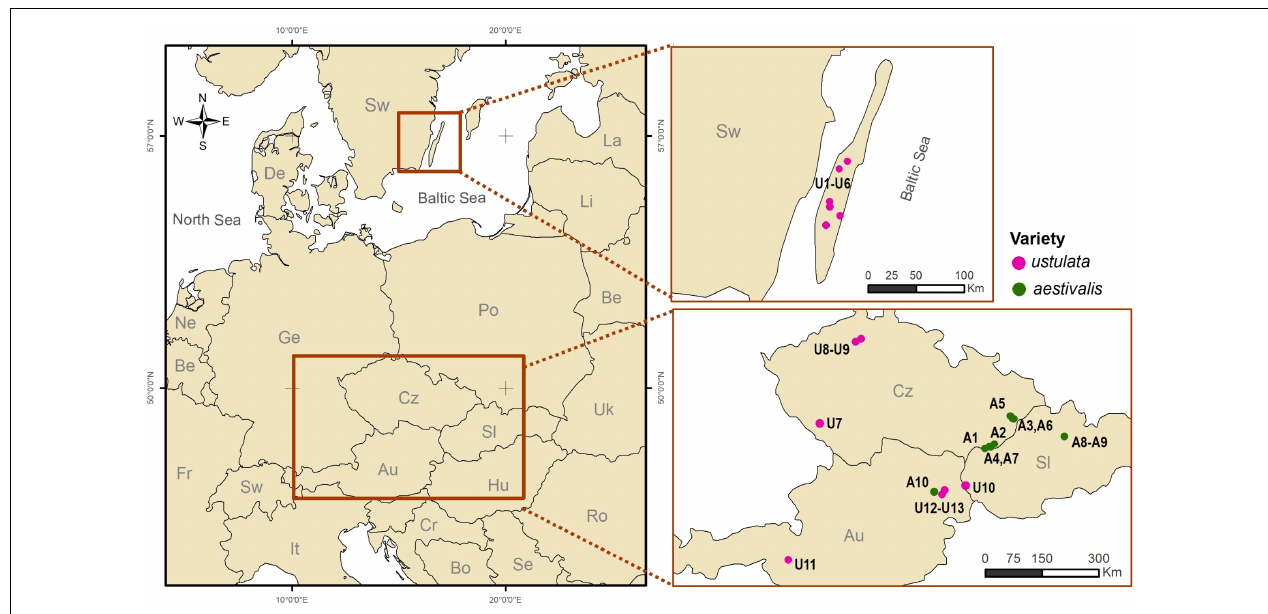
FIGURE 2 | Maps showing the localities where field work was carried out in diverse European countries. The variety identity of Neotinea ustulata populations is indicated by circle colors (violet: var. aestivalis ; green: var. ustulata ). Populations codes follow Supplementary Table 1